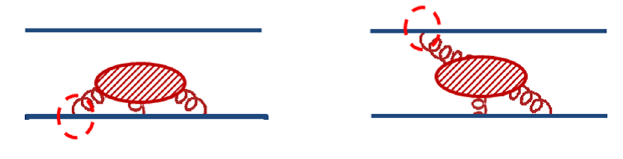
Figure 8 . To take into account the couplings of a gluon to the total static currents, both self- energy and potential-energy diagram contributions need to be included, and a cancellation takes place between them in the IR limit of the gluon momentum j ~q j !